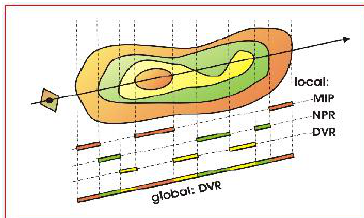
Figure 3. Two conceptual levels of volume rendering